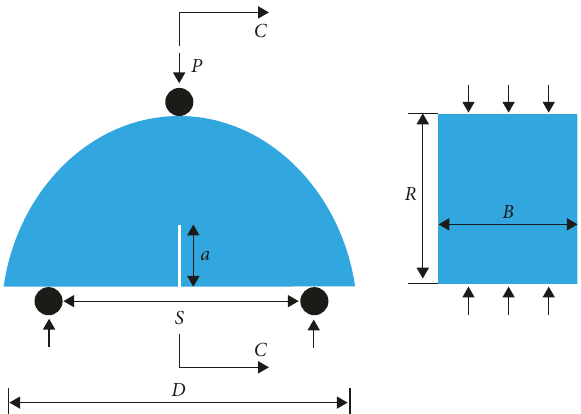
Figure 1: SCB specimen geometry. R , sample radius; B , sample thickness; a , precrack length; S , support span; P ,